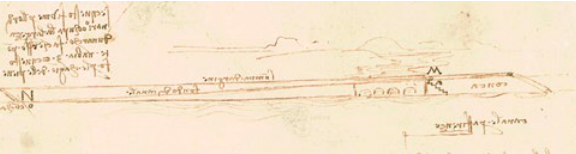
Figure 18. C.A., fol. 126v, detail: cross section of the canal